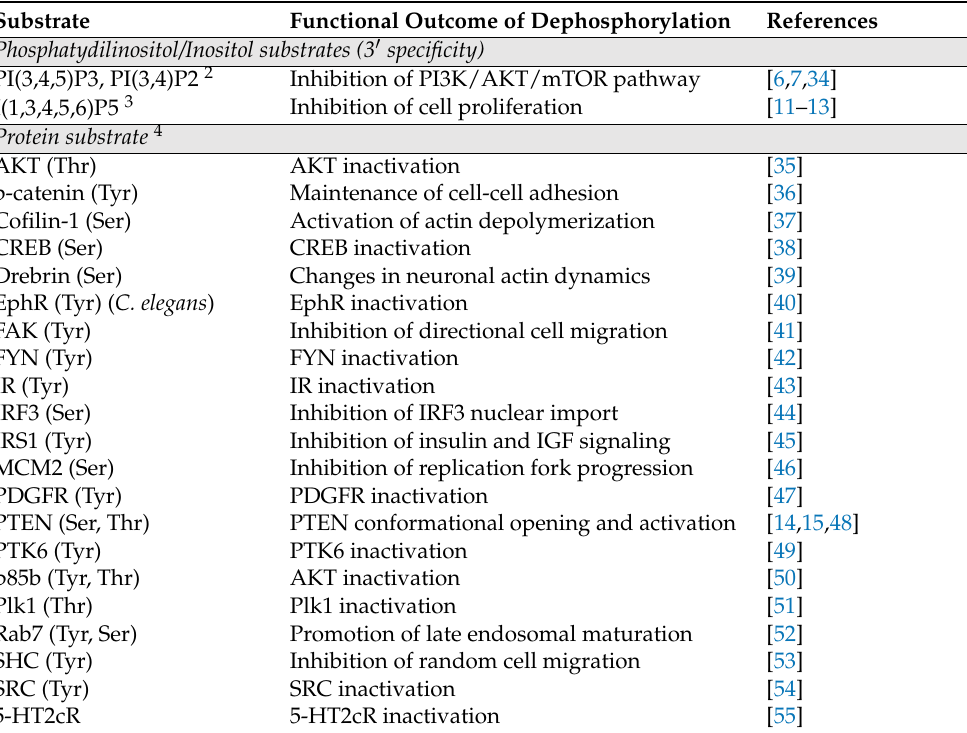
Table 1. Physiologic/potential PTEN substrates 1